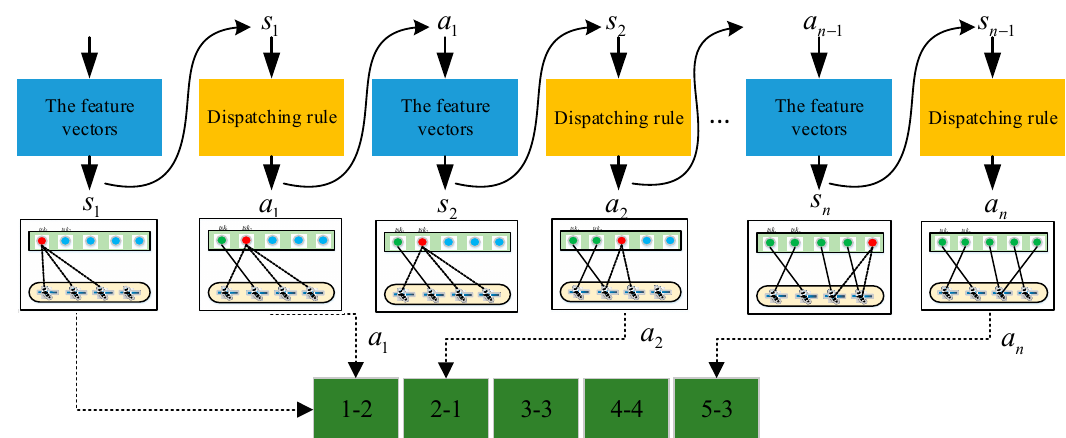
Figure 6. The construction of sequential solutions for task assignment.